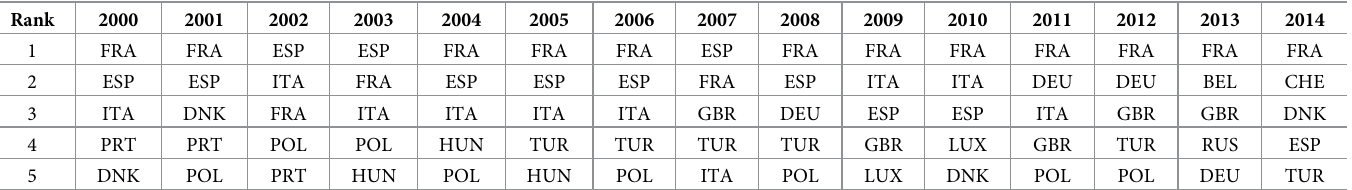
Table 4. Five lowest-potential countries in European community. Rank